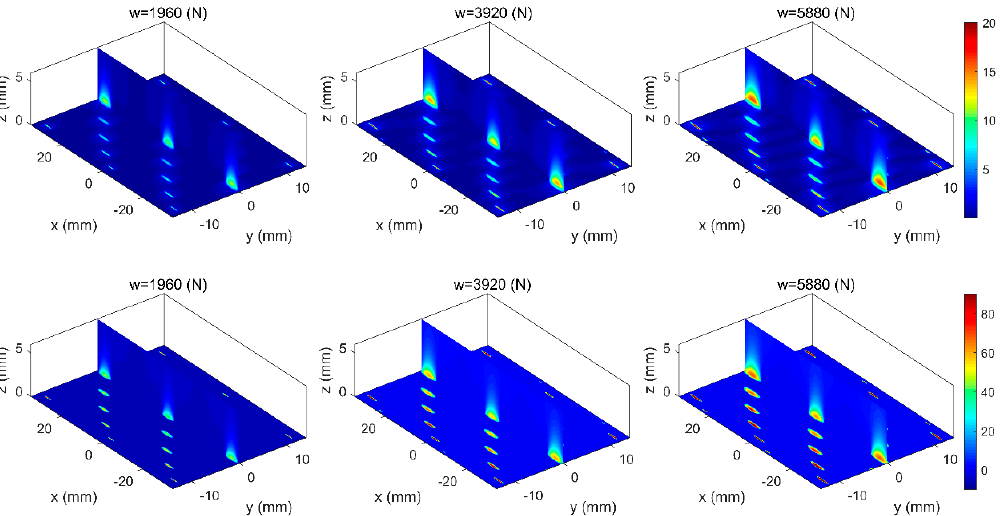
Figure 3. Von-Mises stress, S VM (MPa) (top row) and stress component in z direction, S z (MPa) (bottom row), for w = 1960, 3920, 5880 (N) from left to right. (Please notice the different limit values of the color bars).